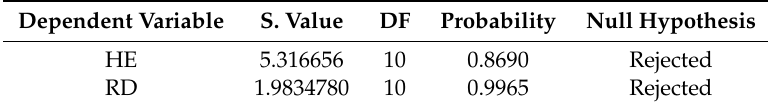
Table 4. Heteroscedasticity